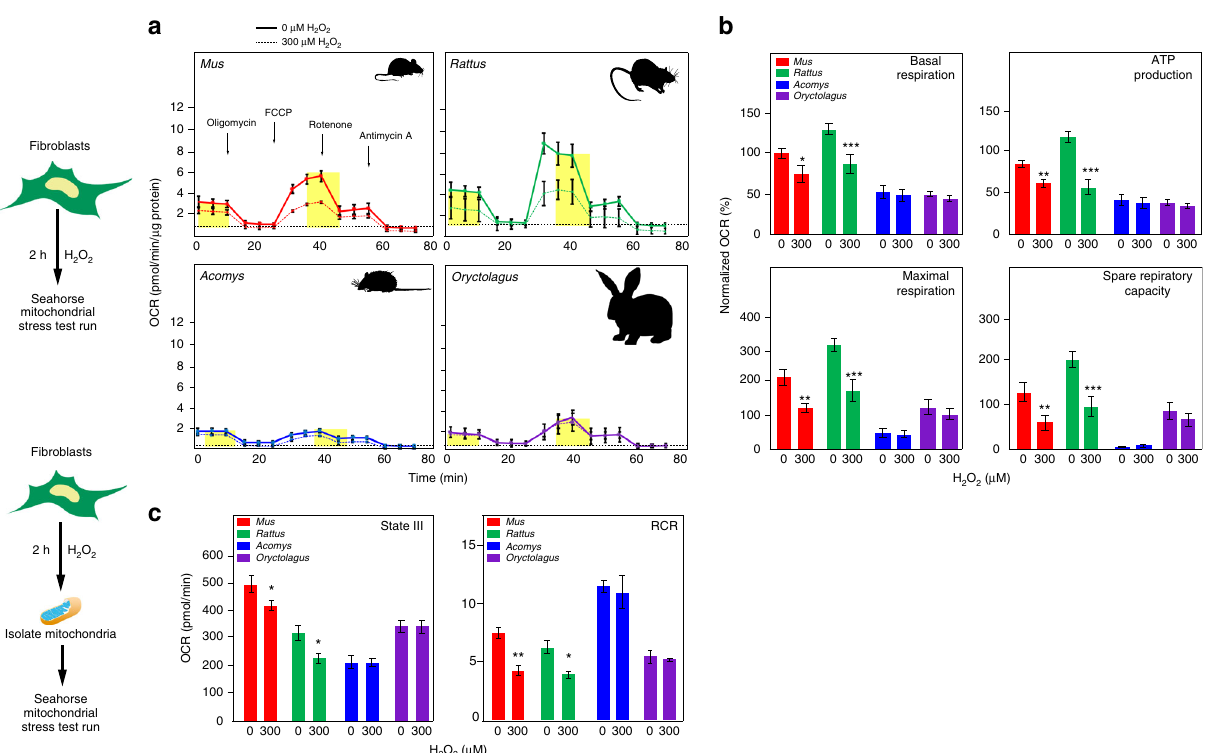
Fig. 6 Mitochondria from regenerating species are resilient to H 2 O 2 . a Mitochondria stress testing measured as OCR (pmol/min/ μ g protein) for fi broblasts from all species after control (PBS) and 300 μ M H 2 O 2 treatment. Mitochondrial complex inhibitors were used to generate measures for basal respiration, maximal respiration, ATP production, and spare respiratory capacity. b Measured OCR was converted to percent normalized OCR and we found that all measured parameters were signi fi cantly decreased in fi broblasts from non-regenerating species: basal respiration (ANOVA, F = 15.8779, P < 0.0001), ATP production (ANOVA, F = 25.2168, P < 0.0001), maximal respiration (ANOVA, F = 20.2582, P < 0.0001), and spare respiratory capacity (ANOVA, F = 15.0920, P < 0.0001) ( n = 5/species). c The mitochondria were isolated from all the species after 0 μ M H 2 O 2 (control) or 300 μ M H 2 O 2 treatment ( n = 3/ species). Mitochondria assays were performed on a XF96 analyzer using ADP + pyruvate/malate and mitochondrial inhibitors oligomycin, FCCP and Antimycin A. State III respiration was achieved through ADP stimulated respiration whereas State IV respiration was calculated after oligomycin inhibition. The Respiratory Control Rate (RCR) was calculated as the ratio of State III and State IV respiratory rate. The OCR for State III and RCR was signi fi cantly decreased after H 2 O 2 treatment in puri fi ed mitochondria of non-regenerators while no signi fi cant effect was shown by regenerators: State III respiration (ANOVA, F = 19.1281, P < 0.0001) and RCR (ANOVA, F = 19.1558, P < 0.0001). Graphics for fi broblast and mitochondria were adapted from open source material. *** P < 0.0001, ** P < 0.001, * P < 0.05. Error bars = S.E.M. Source data are provided as a Source Data fi le rate) provides a measure of how well respiration and phosphor- ylation are coupled. Analyzing the RCR, we found that it too was signi fi cantly decreased in mitochondria from Mus and Rattus after H 2 O 2 treatment (ANOVA, Mus : t = 3.41, P = 0.0035 and Rattus : t = 2.55, P = 0.0215) (Fig. 6c and Supplementary Table 32). Again, and in contrast to the non-regenerating mammals, we found no signi fi cant change in the RCR for mitochondria from Acomys and Oryctolagus (ANOVA, Acomys : t = 0.53, P = 0.6005 and Oryctolagus : t = 0.28, P = 0.7856) (Fig. 6c and Supplementary Table 32). In combination with our assessment of intact cells, our results demonstrate that mitochon- dria from regenerating species are somehow protected from exogenous ROS (or insensitive to it). In contrast, H 2 O 2 exposure destabilizes mitochondria and reduces cellular metabolic rate in fi broblasts from non-regenerating mammals. These data also suggest that mitochondrial dysfunction in response to injury stress may be a source of increased ROS production and senescence in non-regenerators compared to regenerators.